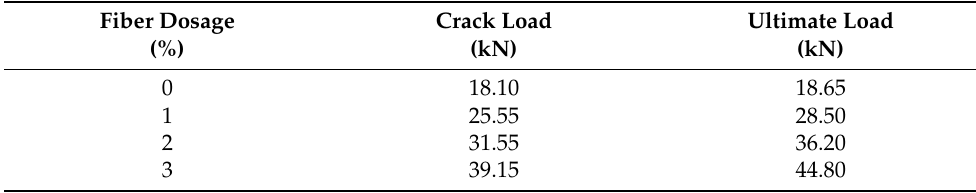
Table 6. Flexural load results of UHPC tunnel lining segments.